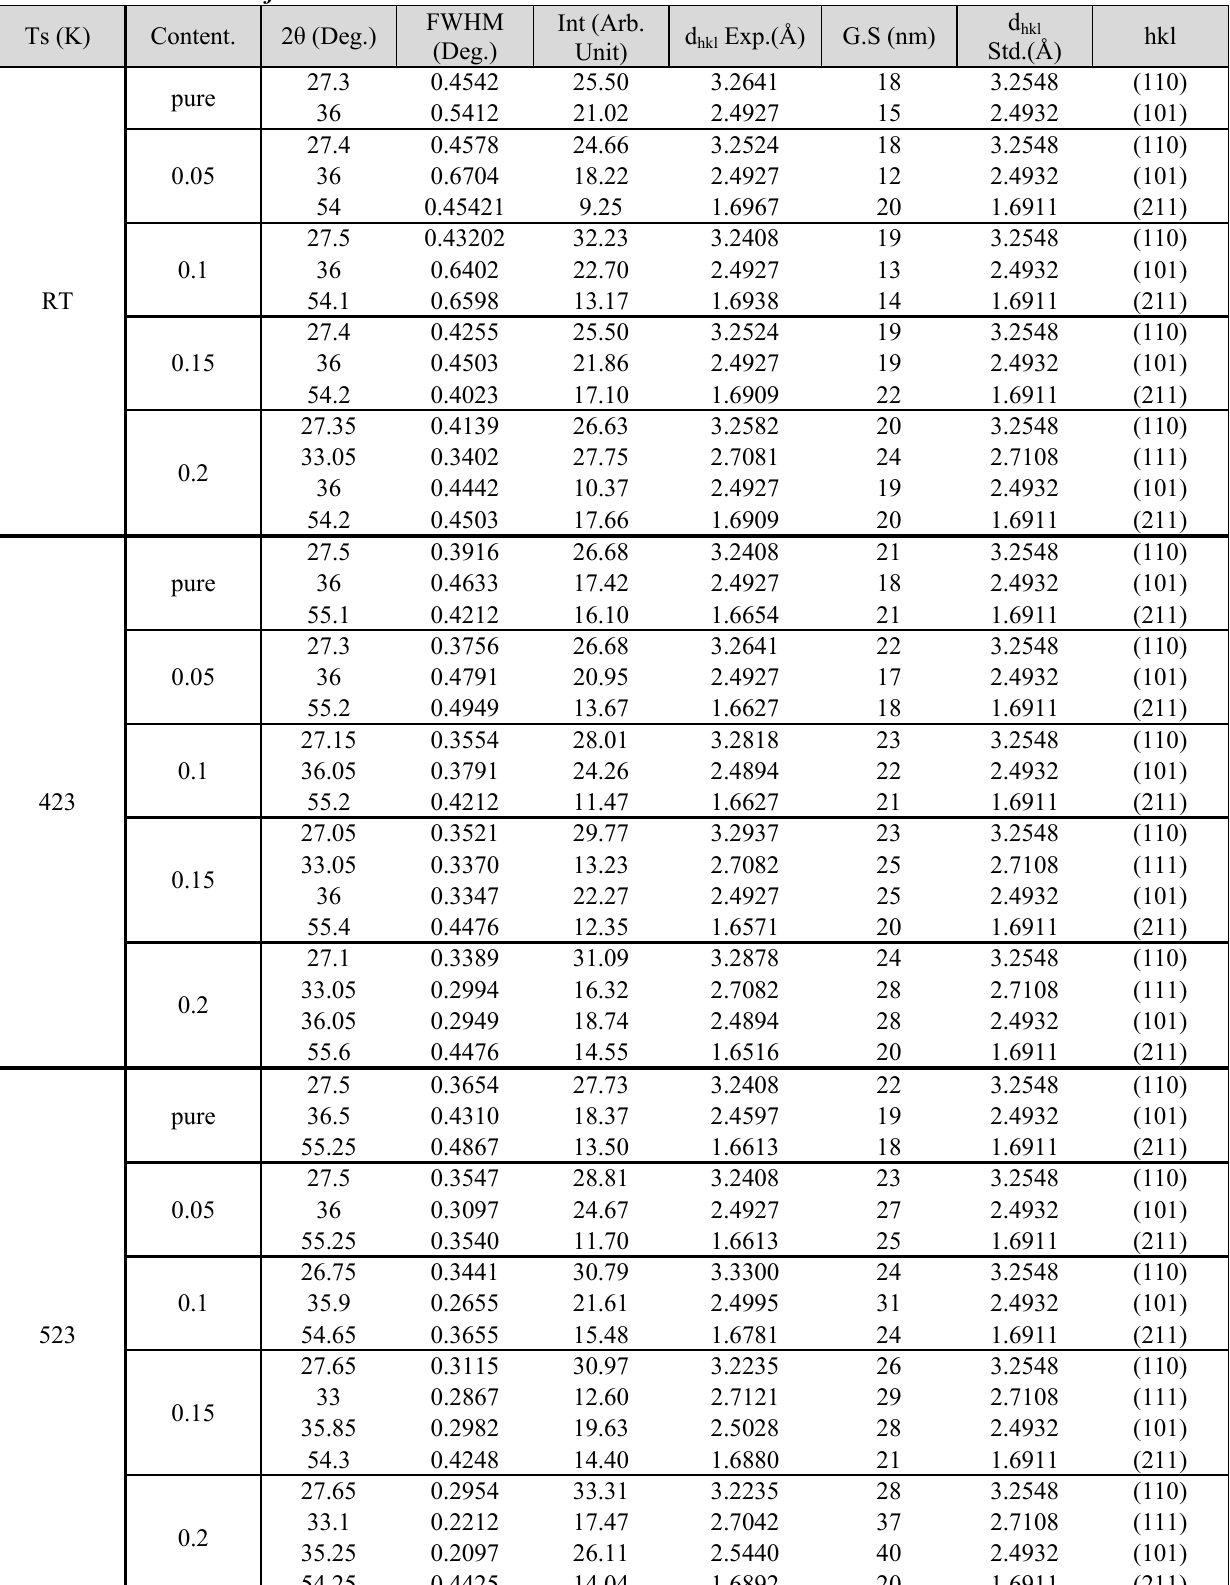
Table 1: The peaks and its Bragg's angle, interplanar distance, and full width half at maximum for TiO : CdO thin films at different annealing temperatures and different 2 concentration of